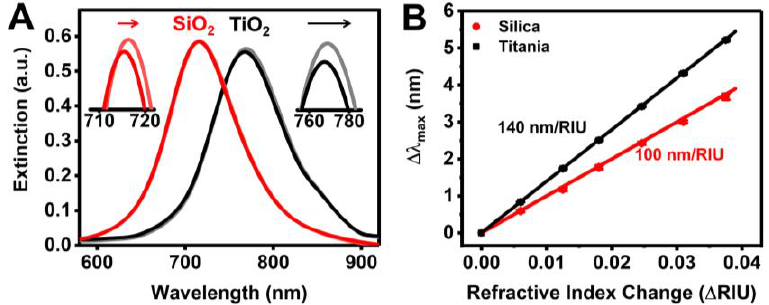
Figure 2. ( A ) LSPR spectra before and after HSA adsorption onto the two sensor surfaces; ( B ) Bulk refractive index sensitivity measurements from water-glycerol titration measurements (0–30 wt % glycerol). Data are reported as mean and standard deviation for n = 3 measurements.